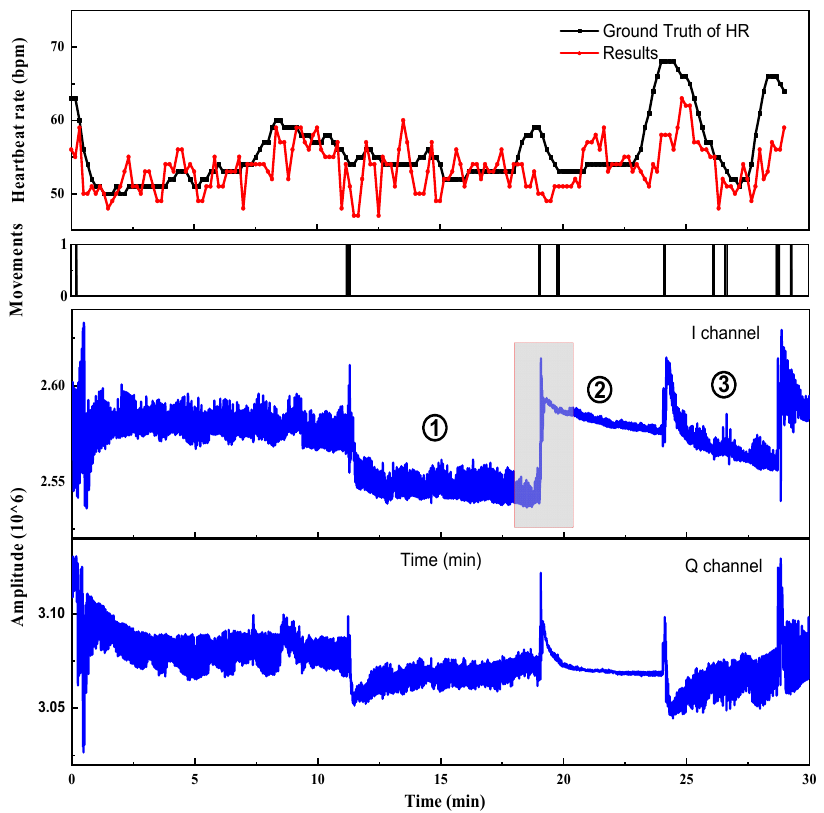
Figure 10. HR results in sleep state for about 30 min ( top ), motion detection results ( middle ), and time-domain diagrams of two orthogonal channels data ( bottom ). There is a corresponding relationship between the time with a large amplitude change in the time domain and the time with a large error in the obtained result. The red box shows the signal region with a posture change from supine to side, whose amplitude is greatly reduced.